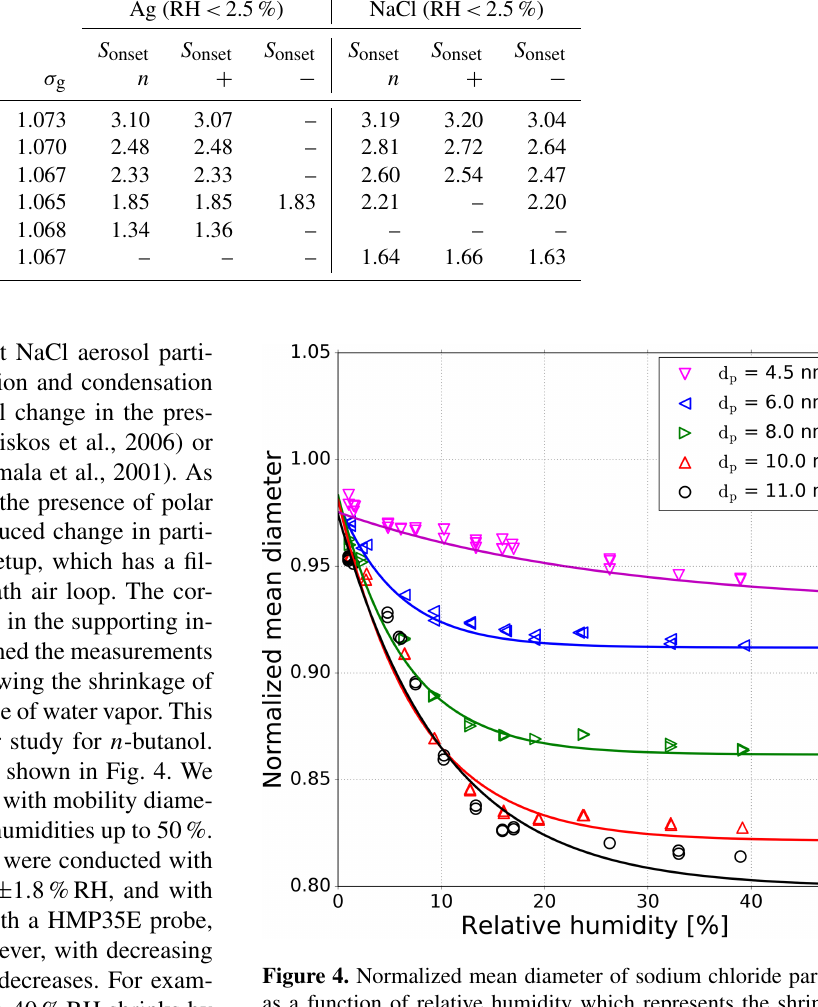
Table 2. SANC experimental results for the onset saturation ratio for neutral ( n ), positively ( + ) and negatively ( − ) charged particles. D p is the mean mobility equivalent diameter, σ g the mean geometric standard deviation and S onset the onset saturation ratio. Ag (RH < 2.5%)